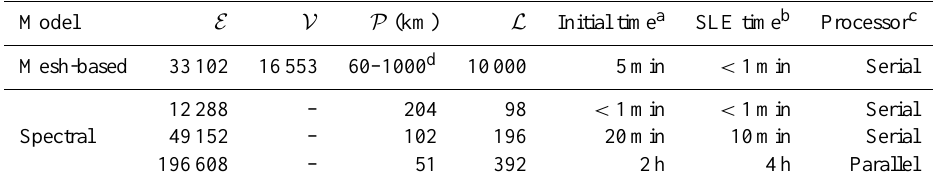
Table 2. Comparison of pseudo-spectral and mesh-based computations of the SLE. We denote element (or pixel) size by P , number of elements (or pixels) by E , number of vertices by V , and the degree at which (associated) Legendre series is truncated by L . ( V is not relevant for the pseudo-spectral